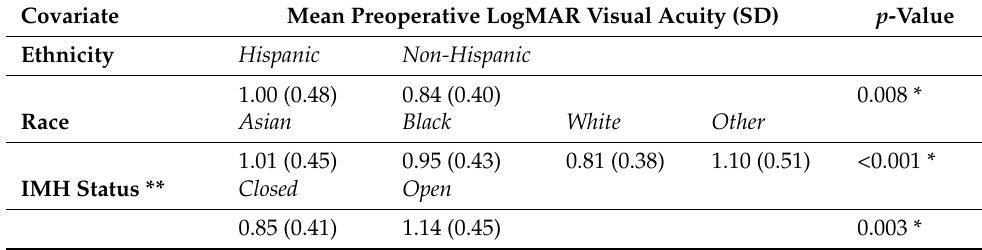
Table 3. Preoperative logMAR VA of the study eyes categorized by ethnicity, race, and IMH clo- sure status.